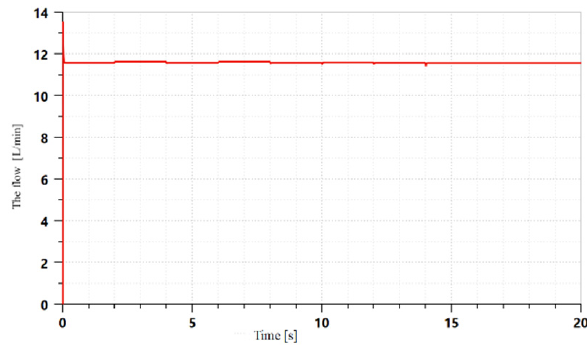
Figure 15. Viscous damping coefficient of 100 N/(m·s).